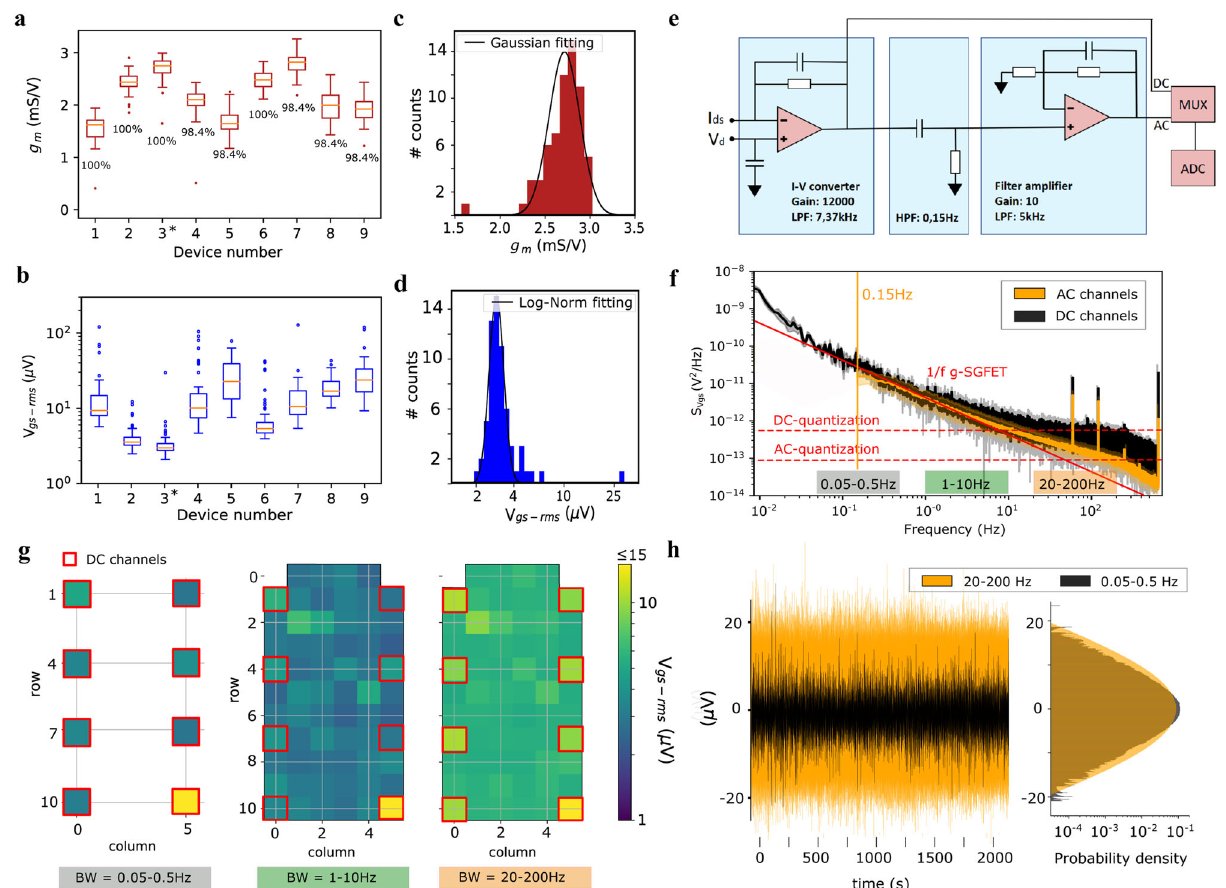
Fig. 2 Evaluation of system sensitivity. a Boxplot of g m for nine randomly selected probes from three different wafers produced in independent batches. The yield in terms of g m above 70% of the median is indicated. b Boxplot for V gs-rms measured in the 1 – 10 Hz frequency range, plotted for the same neural probes evaluated in part a . All probes consisting of 64 g-SGFETs. The boxes extend from the lower to the upper quartiles, with a line at the median. The whiskers extend 1.5 times the inter-quartile range and the data points beyond the whiskers are indicated by a dot. c Histogram of g m for the 64 g-SGFETs of probe #3 (labeled in panel a ) and Gaussian fi t of the histogram excluding the outliers shown in panel a . d Histogram of V gs-rms for the 64 transistors in probe #3 (see panel b ) and log-normal fi t of the histogram excluding the outliers shown in panel b . e Equivalent circuit of the wireless headstage. f Power spectral density (PSD) of the noise from DC channels (black) and AC channels (orange) in probe #3. The 1/f dependence is represented by the solid red line. The vertical orange line indicates the hardware high-pass fi lter applied to AC channels at 0.15 Hz. The quantization noise of the DC and AC channels is indicated by the horizontal dashed red lines. g Representation of the V gs-rms for all g-SGFETs in probe #3 shown for different bandwidths; 0.05-0.5 Hz band for the DC-channels (left), 1 – 10 Hz band (middle), and 20 – 200 Hz (right). The position of the g-SGFETs on the array connected to DC-channels of the headstage is indicated by the red squares. h Time domain representation of the noise spectra shown in part f and g (DC-channels fi ltered in the 0.05 – 0.5 Hz band and AC channels in the 20 – 200 Hz band). Signal from eight channels are